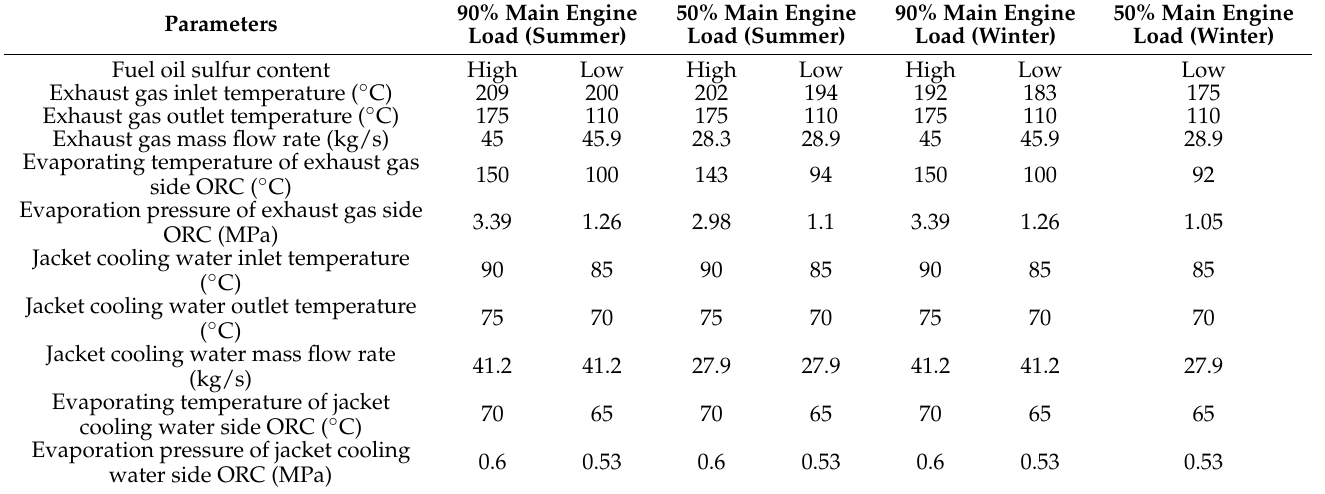
Table 8. ORC system operating